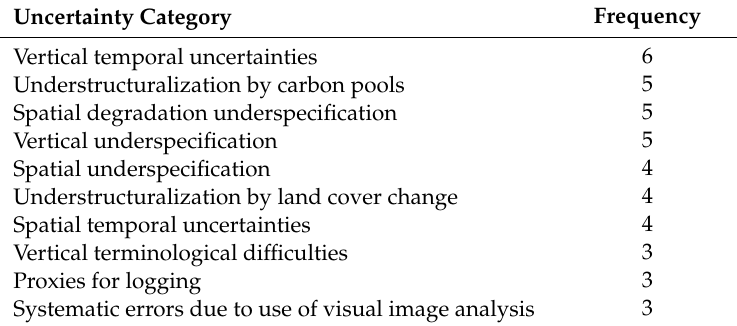
Table 9. Priorities for enhancing forest monitoring in tropical countries, based on the frequency of uncertainty categories in the Uncertainty Fingerprints of the Forest Reference Emission Level (FREL) reports of the comprehensive group of six tropical countries (Figure 7b) [67,69–73]. Uncertainty Category Frequency Vertical temporal uncertainties 6 Understructuralization by carbon pools 5 Spatial degradation underspecification 5 Vertical underspecification 5 Spatial underspecification 4 Understructuralization by land cover change 4 Spatial temporal uncertainties 4 Vertical terminological di ffi culties 3 Proxies for logging 3 Systematic errors due to use of visual image analysis